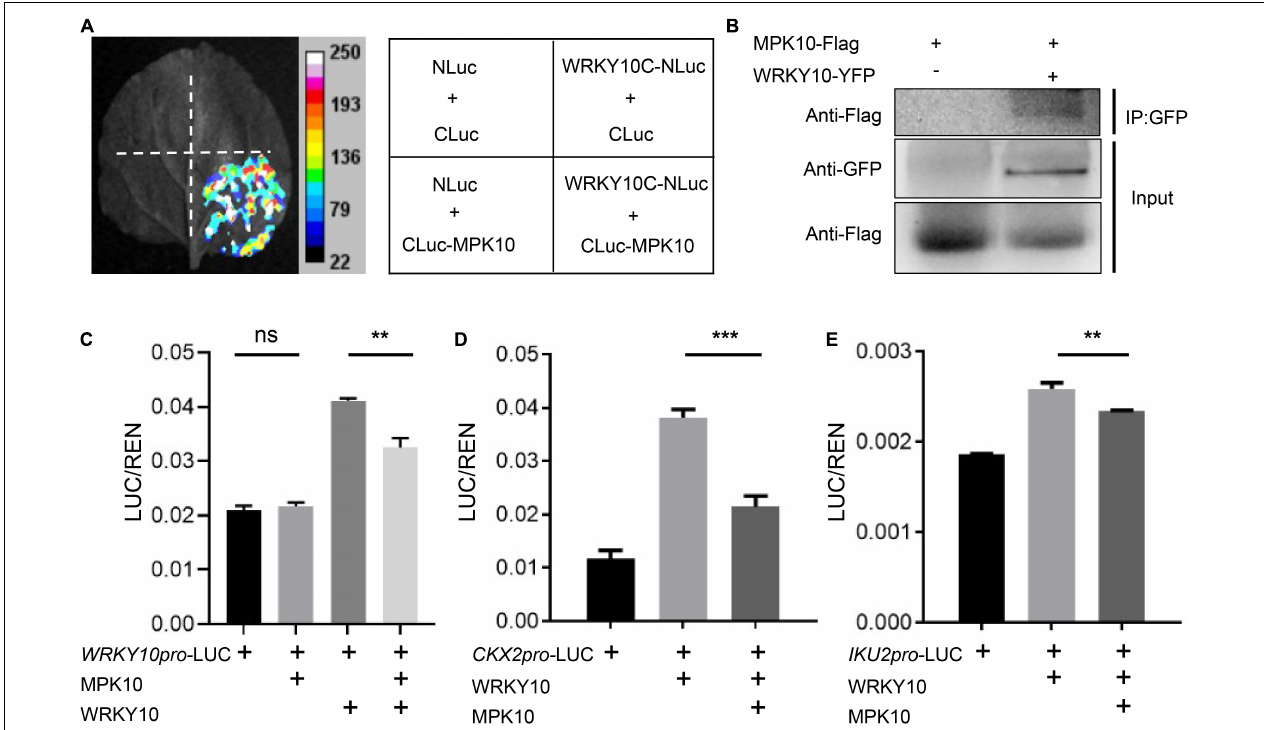
FIGURE 4 | MPK10 suppresses the transcriptional activity of WRKY10. (A) MPK10 interacts with WRKY10 proven by split-luciferase assays. C-terminal 368–485aa of WRKY10 was used in the assay. The Agrobacterium suspensions carrying the purposed constructs were co-injected into N. benthamiana leaf epidermal cells. The positive luminescence monitored by a CCD camera indicates interaction. (B) MPK10 was coimmunoprecipitated with WRKY10-GFP. Immunoprecipitation was performed using GFP-trap, and western blots were performed using anti-GFP antibody and anti-Flag antibody. (C–E) MPK10 inhibits the transcriptional activation activity of WRKY10 on promoter of WRKY10 (C) and promoters of downstream genes CKX2 (D) , IKU2 (E) . The Agrobacterium suspension of reporters and effectors were co-expressed in N. benthamiana leaf epidermal cells. The relative LUC activities normalized to the REN activities are shown (LUC/REN). Data represent the mean and standard deviation ( n = 3). The statistical significances are determined using student’s t -test. * P < 0.05, ** P < 0.01, *** P < 0.001.